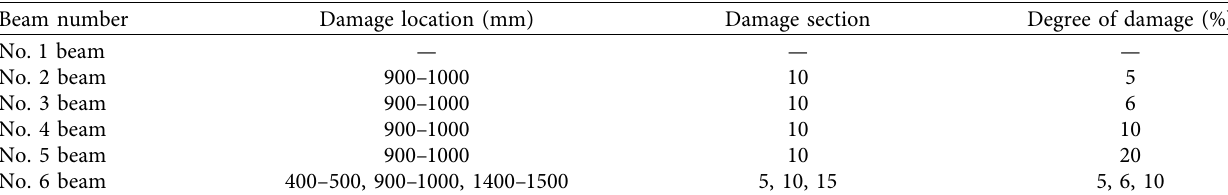
Table 3: List of working